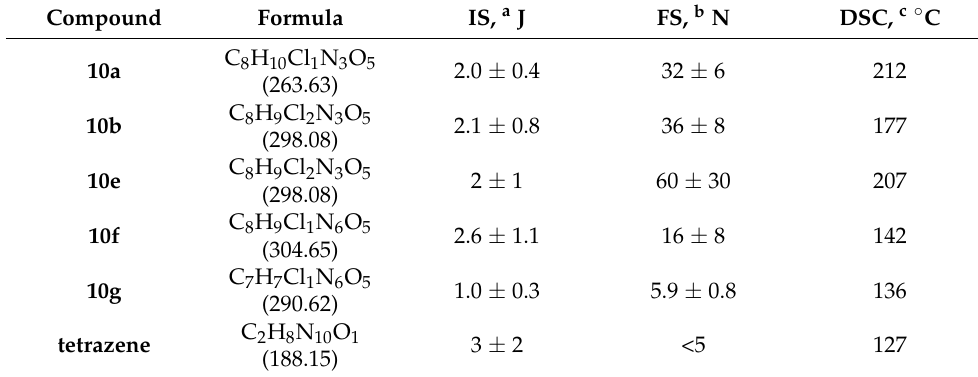
Table 1. Explosive sensitivity for compounds of this study in comparison with tetrazene.